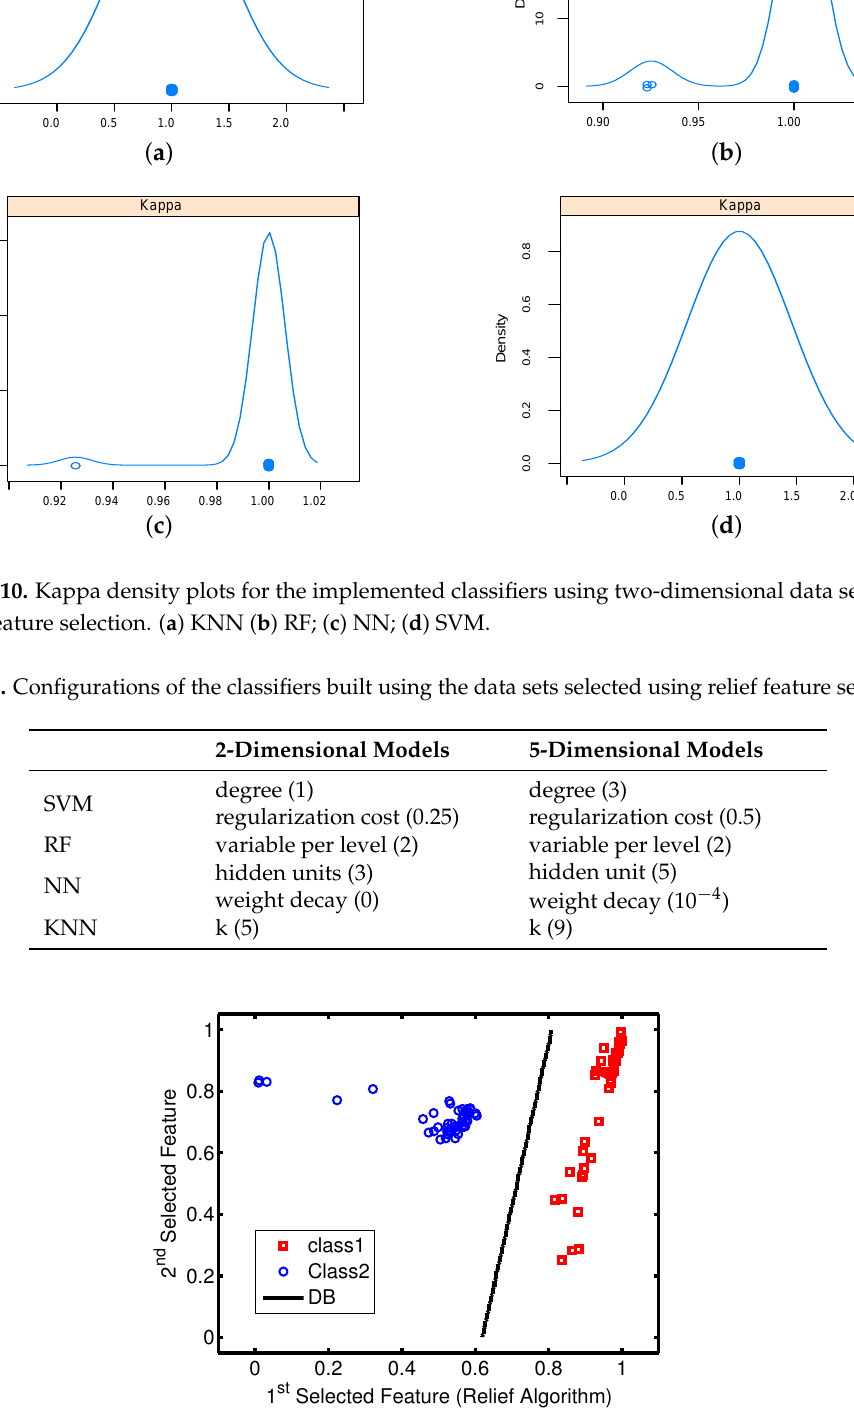
Figure 11. SVM decision boundary (DB) plot and unseen data from both